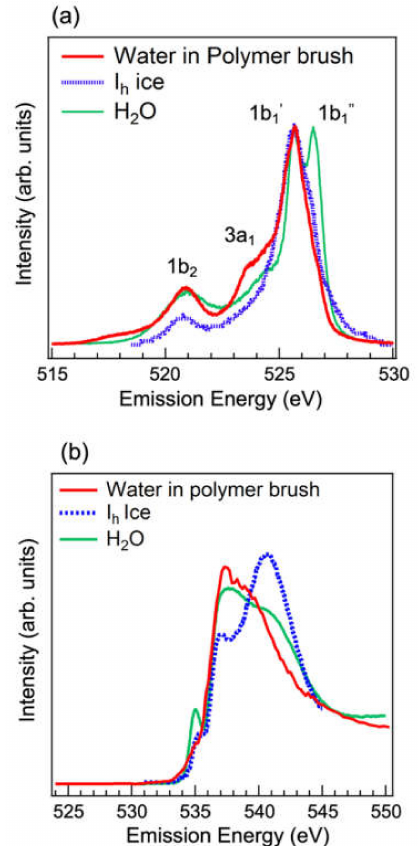
Figure 9. ( a ) O 1s soft X-ray emission spectra of water confined in the polyelectrolyte brush, the dry brush measured in vacuum, liquid H 2 O, and ice I h . The excitation energy is 550.3 eV, which is much higher than the ionization threshold. ( b ) Soft X-ray absorption spectra of water confined in the polyelectrolyte brush, dry brush measured in vacuum, liquid H 2 O at room temperature, and I h ice. Reproduced with permission [42]. 2017, American Chemical